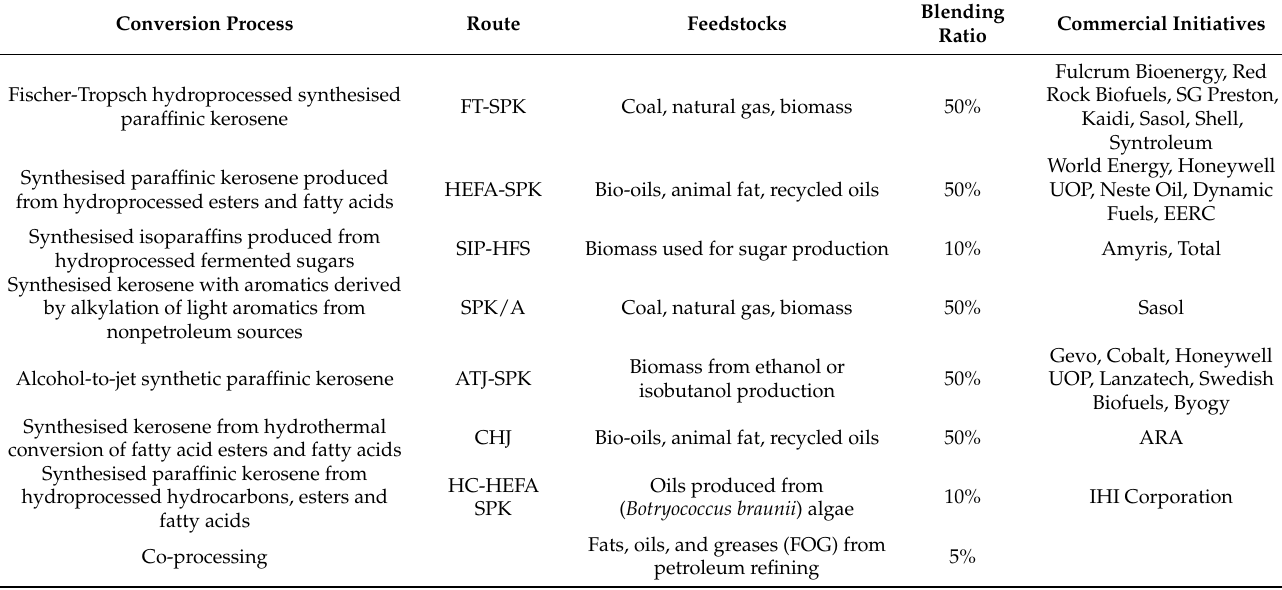
Table 1. Bio-jet fuel production processes approved by ASTM International; the blending ratios are expressed on a volume